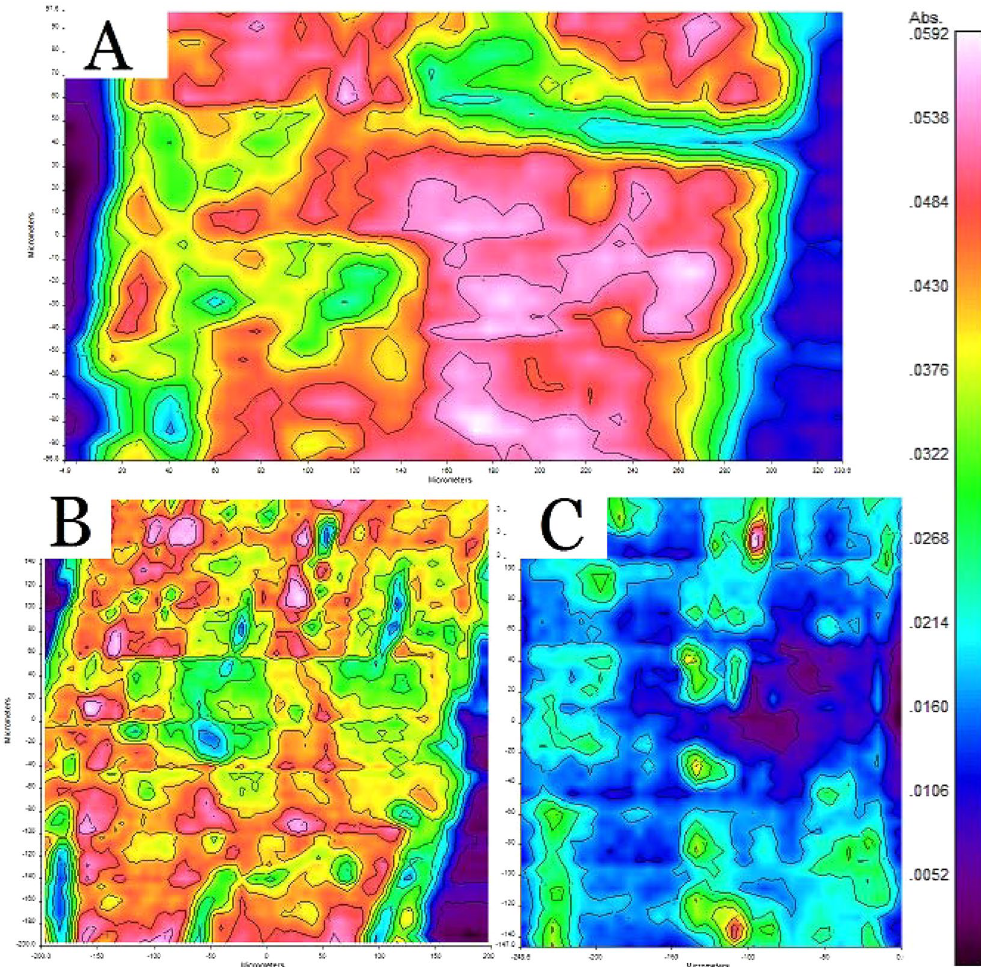
Figure 4. Hemicellulose infrared microspectral images. ( A ) raw kenaf fiber bundle, ( B ) semi-degummed fiber bundle and ( C ) degummed fiber